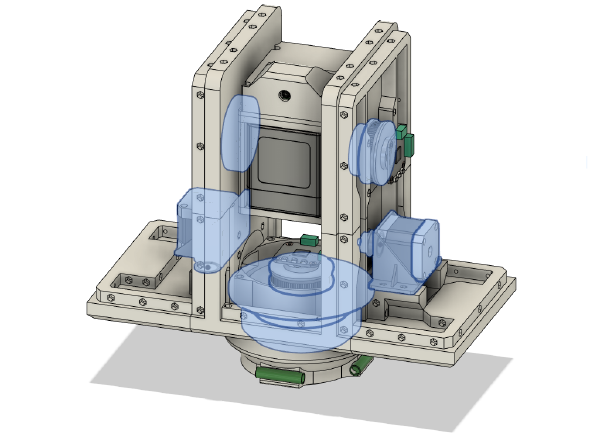
Figure 1. Hardware integration diagram